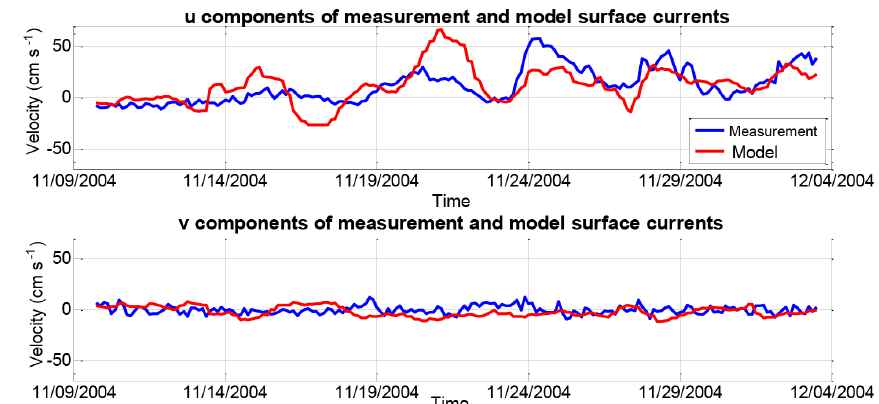
Figure 5. Comparison of numerical model results of surface current components and observations near the Sefid Rud River and the Anzali Port (Shiea et al., 2016).